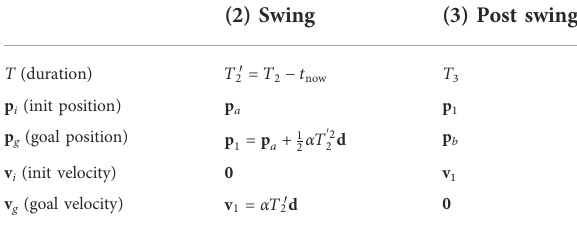
TABLE 2 Revised CoM parameterization for the swing phase re- planning.